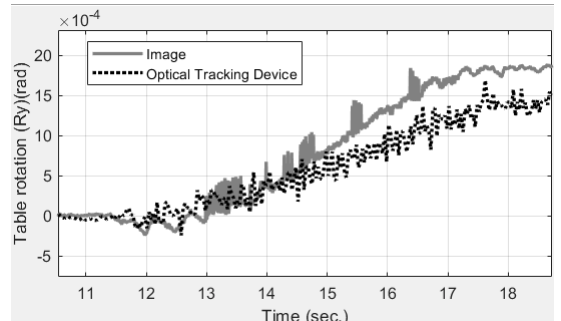
Figure 15. Table rotation (along the y axis) estimated by image analysis and an optical tracking device. Image analysis measures table rotation, which is difficult to measure by conventional sensors.